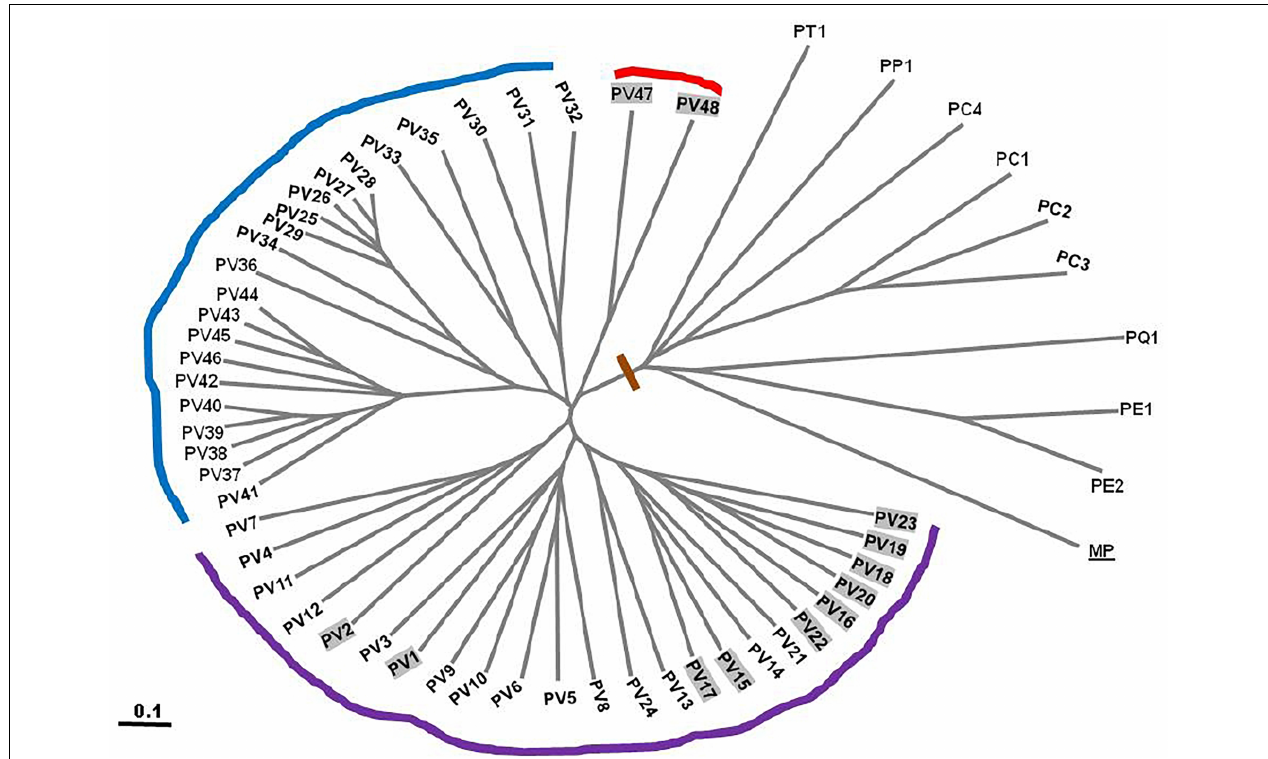
FIGURE 4 | UPGMA dendrogram of cumulative band data for 57 genotypes of Pteris depicted in a radial form after 1000 replicate bootstrap. PV1–PV 57 –57 genotypes of P. vittata from various locations of India (Table 1). PE: P. ensiformis , PQ: P. quadriaurita , PT : P. tremula , PC: P. cretica , PP: P. pellucida , MP: Microsorum punctatum